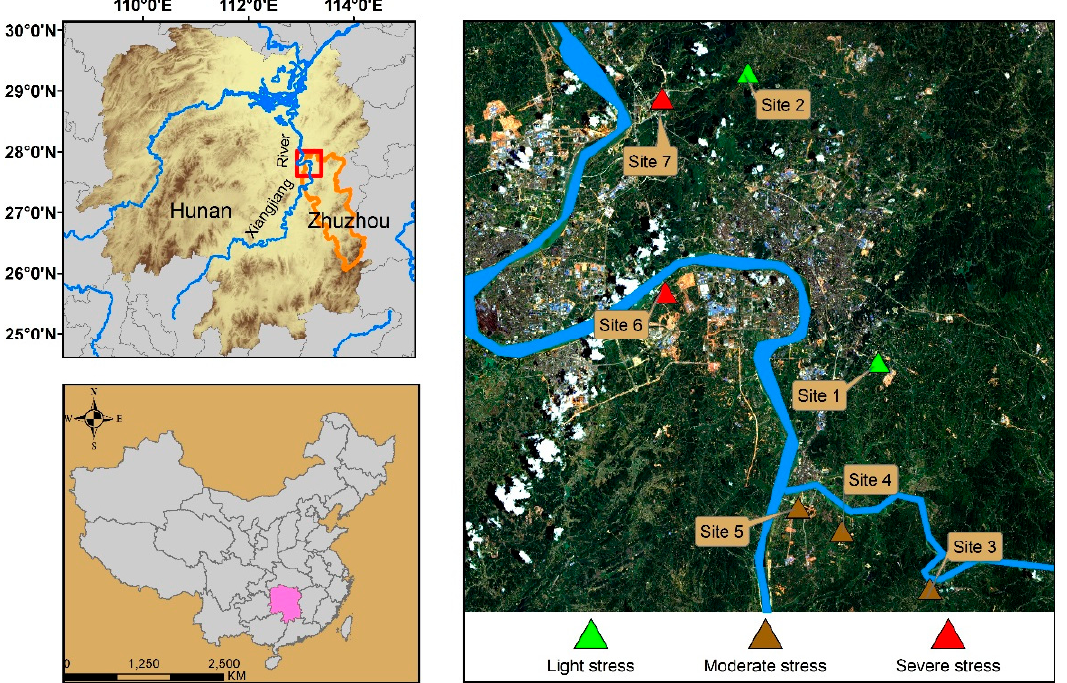
Figure 1. The location of the study area and the distribution of study sites (The green triangles represent the study sites under a light stress level of heavy metal, the dark brown triangles represent the study sites under a moderate stress level of heavy metal, and the red triangles represent the study sites under a severe stress level of heavy metal).